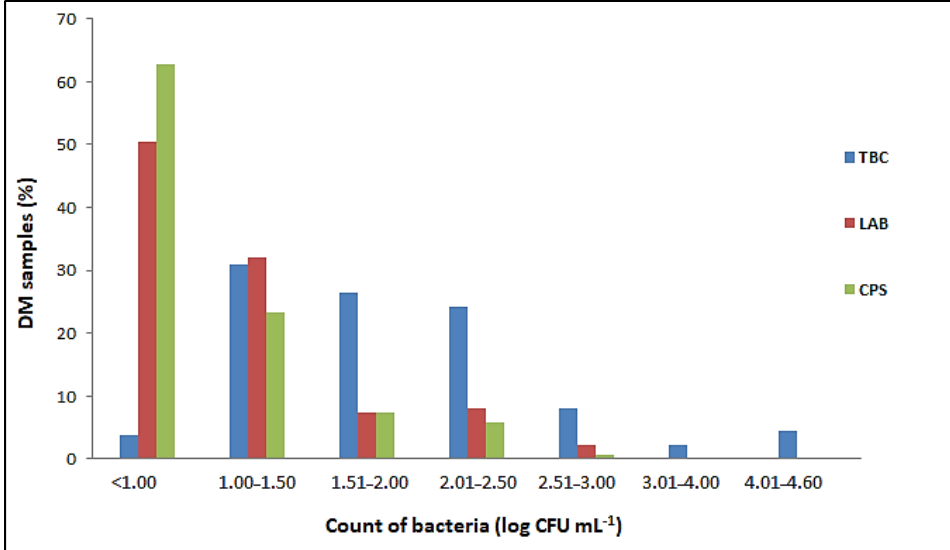
Figure 1. Proportion of DM samples with different ranges of bacterial counts.